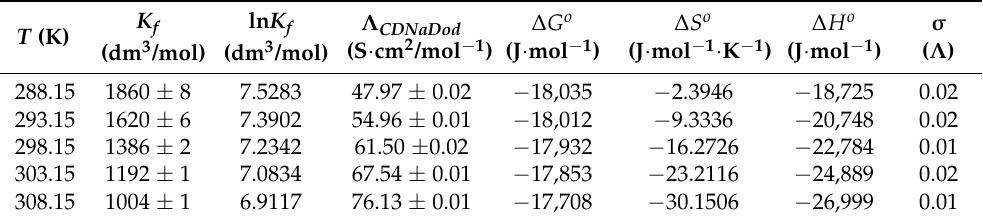
Table 4. The value of formation constant K f (dm 3 /mol), theoretical conductivity Λ CDNaDod (S · cm 2 /mol − 1 ) and the values of thermodynamic functions ∆ G o , ∆ H o and ∆ S o for α -cyclodextrin with the salt of trans -caffeic